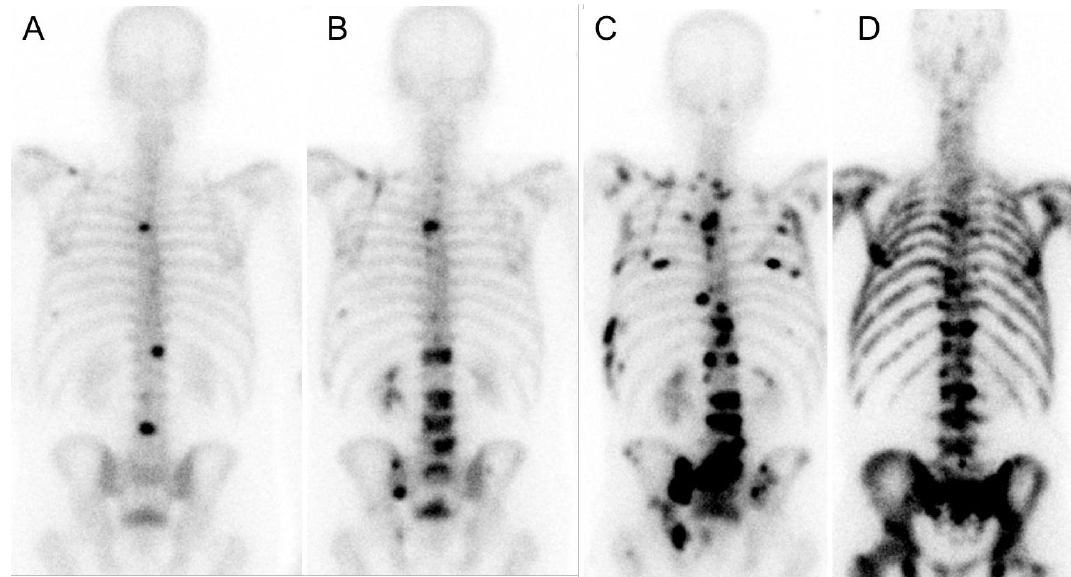
Figure 3. Bone scans performed with [ 99m Tc]Tc-phosphonate in prostate cancer patients. ( A ) Initial patient scan visualizing well-defined oligo metastases. ( B , C ) At later time points, 400 days after initial scanning ( B ) and 800 days after initial scanning ( C ), the number of well-defined metastases increased despite continued systemic treatment; ( D ) A typical patient with diffused visualized metastases in the skeleton.